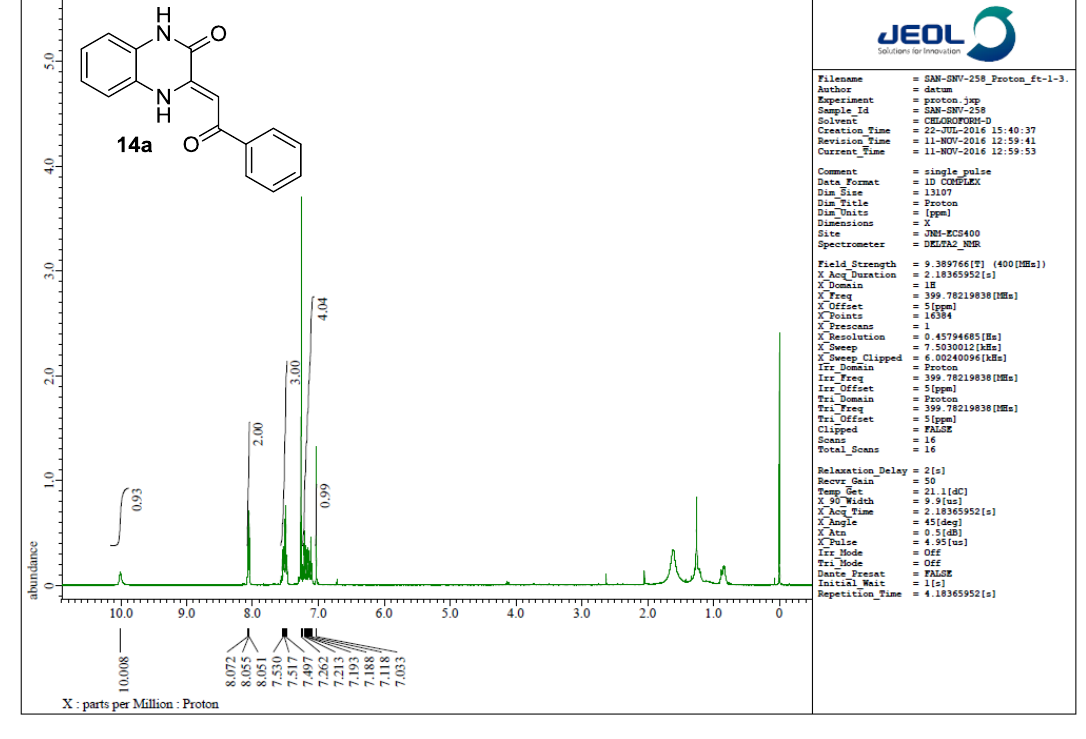
Figure 29 . 1 H NMR Spectra of Compound 14a .